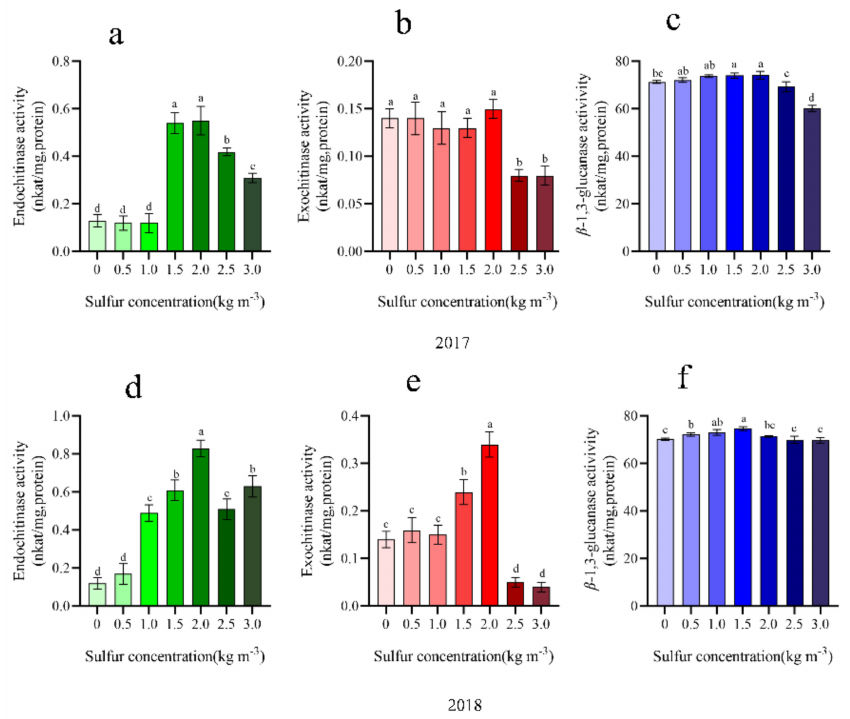
Figure 8. Effect of different sulfur treatments on chitinase and β -1,3-glucanase activities in the leaves of kiwifruit. Differ- ent letters indicate significant difference between means at p < 0.05. ( a ) Endochitinase activity in kiwifruit leaves in 2017; ( b ) Exochitinase activity in kiwifruit leaves in 2017; ( c ) ß -1,3-glucanase activity in kiwifruit leaves in 2017; ( d ) Endochitinase activity in kiwifruit leaves in 2018; ( e ) Exochitinase activity in kiwifruit leaves in 2018; ( f ) ß -1,3-glucanase activity in kiwifruit leaves in 2018.